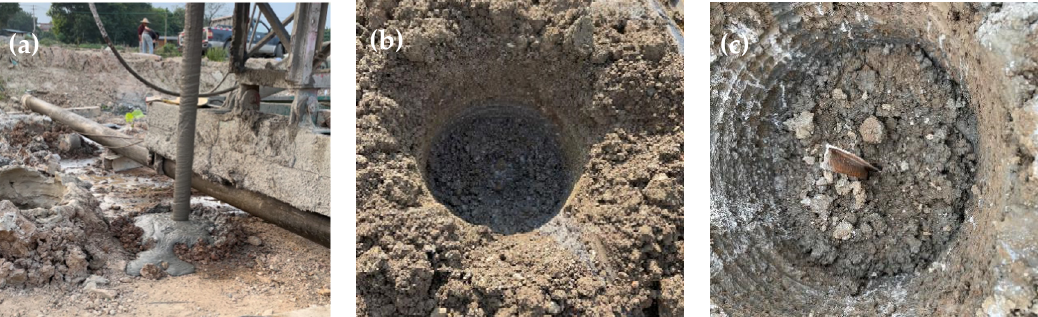
Figure 6. Influence of mixing times on oozing slurry of a mixing pile: ( a ) two, ( b ) four and ( c ) six.